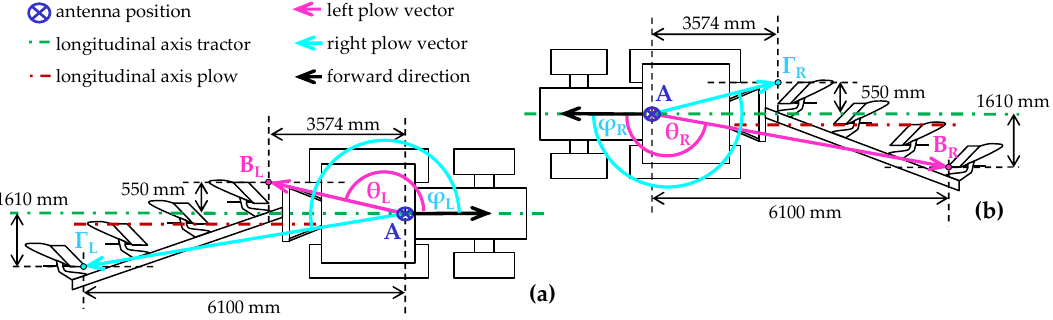
7 Figure 7. Schematic operating principle of the algorithm for the distinction between main part passes and headland passes. To distinguish the two headlands of every field, k-means clustering was performed on their D- GNSS data. The MATLAB function “kmeans” was using a k-means++ algorithm according to Arthur and Vassilvitskii [20]. The number of clusters was manually pre-set to a value of two according to the number of headlands. 2.7. Modeling of the Representative Plow Points As a preparatory step, relevant sizes were taken from the real tractor–implement combination, whereby the working width was set to its maximum. In Figure 8, the modeling of the representative plow points is schematically illustrated and the relevant dimensions are indicated. Figure 8a shows